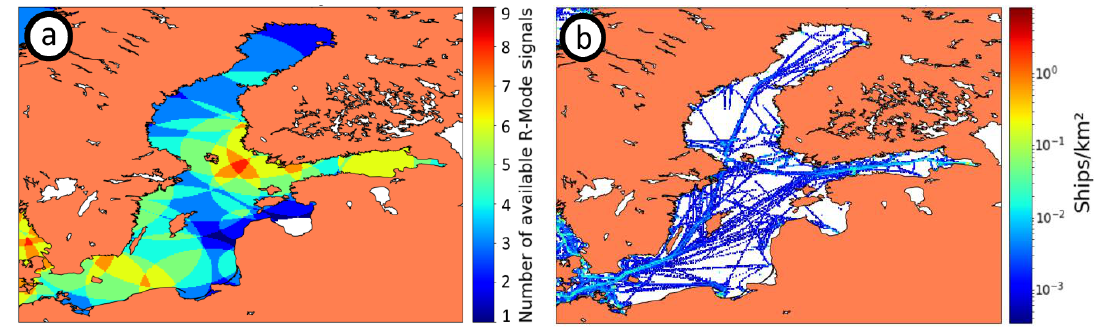
Figure 12. Comparison between the potential R-Mode coverage in the Baltic Sea ( a ) and the traffic density in the same area ( b ).